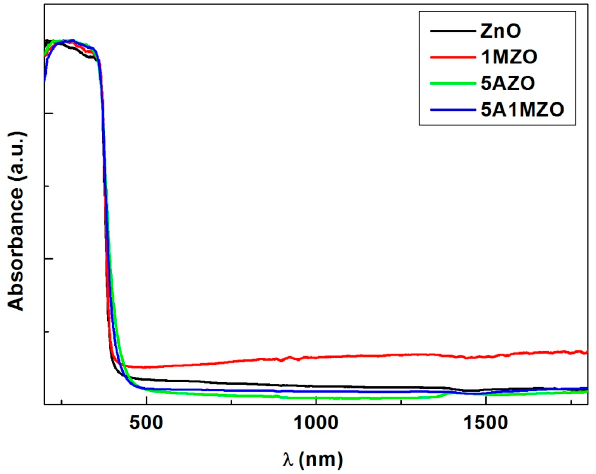
Figure 8. UV-Vis spectra of ZnO, 1MZO, 5AZO and 5A1MZO samples.